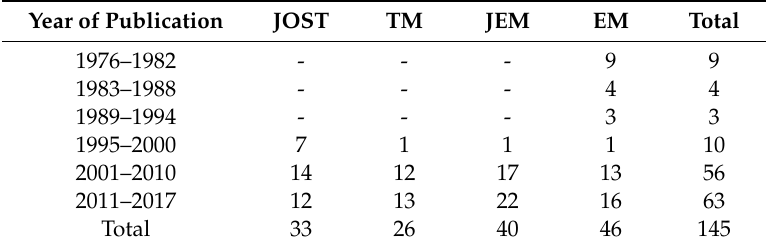
Table 1. Number of recreational ecology papers by year (JOST, TM, JEM, EM 1976–2017). Year of Publication JOST